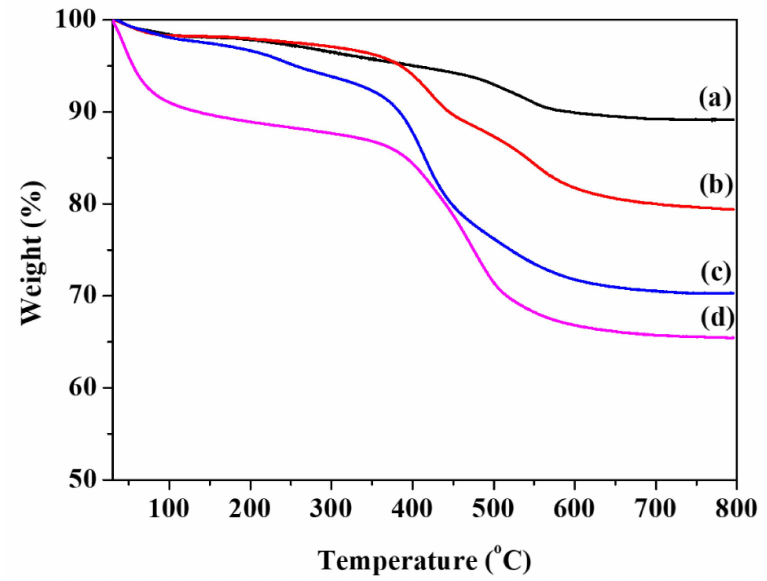
Figure 6. TGA curves of ( a ) MCM-41, ( b ) MCM-41-TMSPM, ( c ) MCM-41-PAA, and ( d ) Ca@MCM-41-